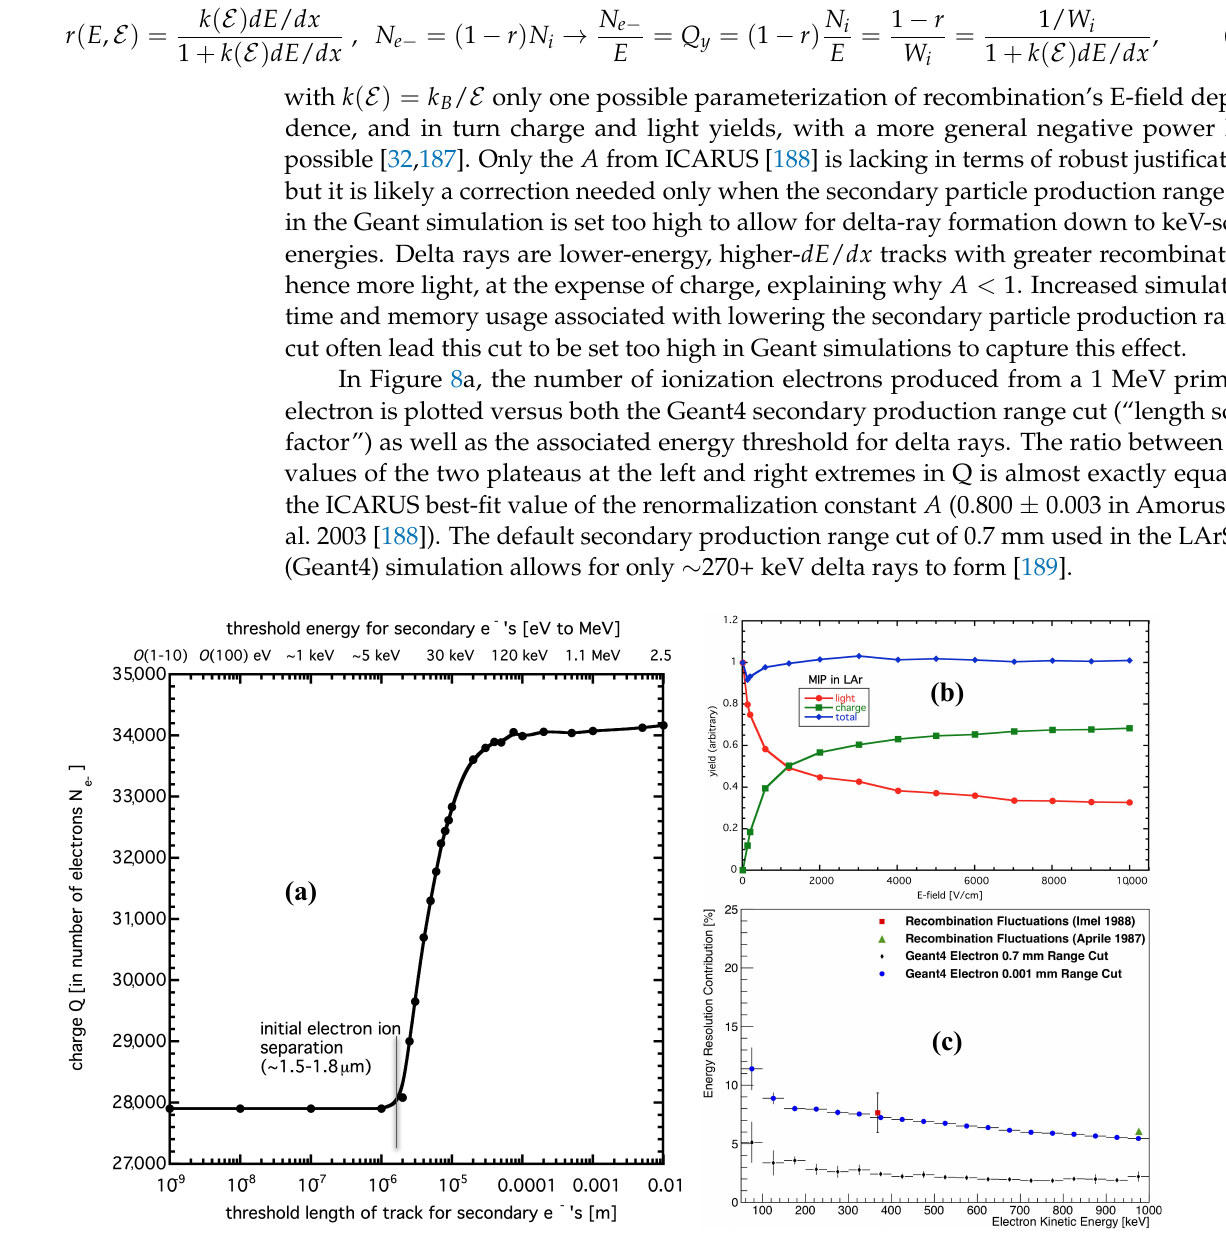
Figure 8. ( a ) Lack of delta rays in Geant4 altering median Q at 1 MeV in a large 500 V/cm LAr volume, more so as the threshold in track length set by the user for creation of secondary e − s increases past the value from Mozumder [190]. The default threshold is typically too high by > 10 times, in length and/or E , in neutrino simulations [189]. ( b ) Demonstration of S versus Q anti-correlation from our reanalysis of Doke et al. 1988 and 2002 [78,169], confirmed by the recent Liquid Argon In A Test beam (LArIAT) study [180]. A 1 MeV ER at different E-fields, as opposed to many E s at one E-field (as done for a contemporary “Doke plot”). ( c ) Noiseless charge-only resolution vs. fixed electron E using Geant4, with G4 secondary production range cuts of 1 µ m (blue) and 0.7 mm (black, in LArSoft), compared to data points at isolated E s on recombination fluctuations with delta rays from [186] (red) and [191] (green, no measurement uncertainty provided). Figure 8b (upper right) shows that the lower plateau in the large left plot (a) in its lower left corner is closer to correct. The zero-electric-field light yield for a 1 MeV beta, or other electron, is approximately 41 photons/keV [169] while the red line in (b) shows a reduction to ∼ 0.6 of that value by 500 V/cm, to 24.6 photons/keV. If the work function is 19.5 ± 1.0 eV, as reported also by Doke, this implies a total (S and Q